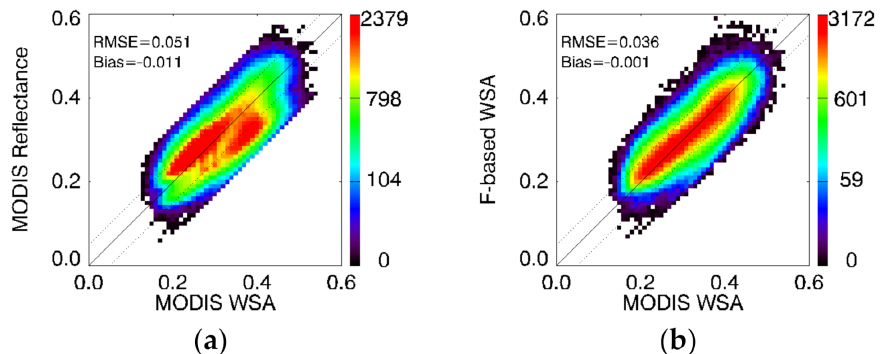
Figure 15. Comparison of MODIS WSA with real MODIS directional observation ( a ) and with F - based WSA ( b ) retrieval from a single directional reflectance. The colors represent the density of the directional reflectance.